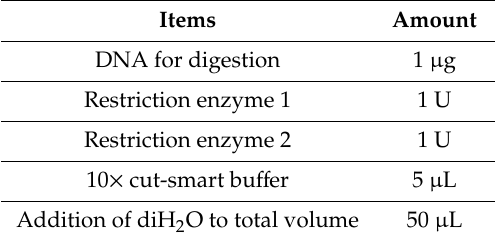
Table 1. Restriction enzyme cleavage reaction configuration.